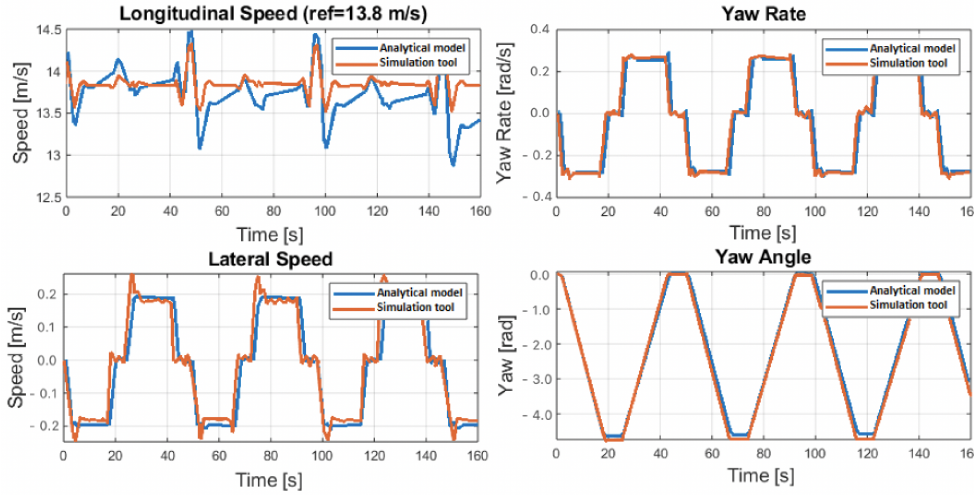
Figure 19. Static speed profile results after sensitivity